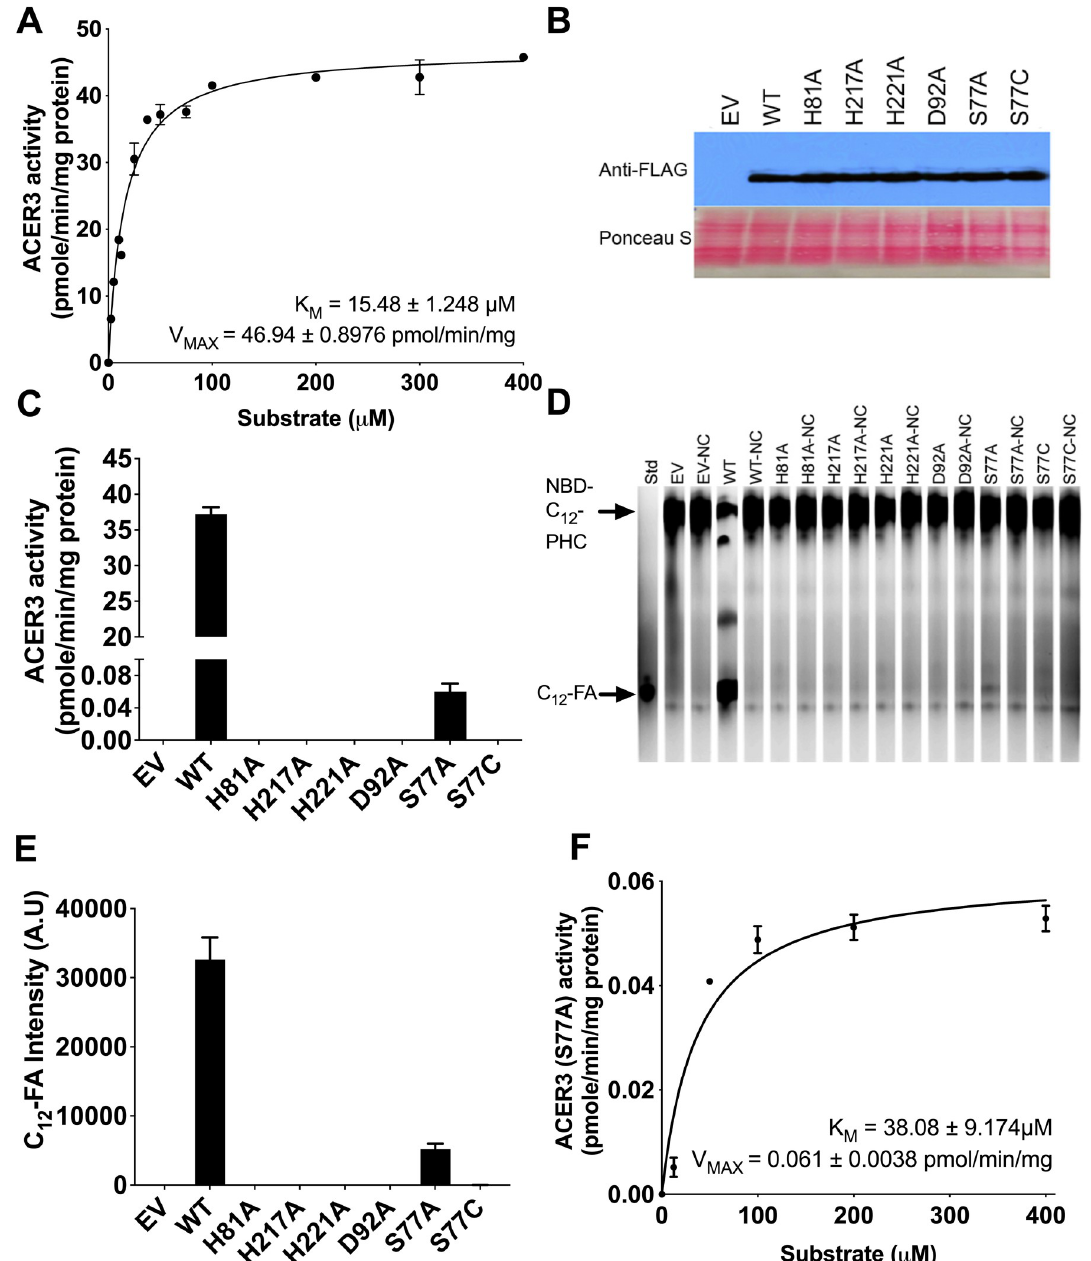
Fig 2. The kinetics of ACER3 and mutants. (A) Microsomes from yeast cells ( Δ Ypc1 Δ Ydc1 )overexpressing wild-type ACER3 were measured for in vitro ceramidase activity on various concentrations of NBD-C12-PHC. K M and V MAX values are indicated. Reactions were conducted with 1 μ g of microsome at 37˚C for 30 min. Data represent the mean ± S.D. of three independent experiments performed in duplicate. (B) Western blot analysis verifying the expression levels of each mutant and wild-type ACER3. For normalization of equal loading, the membrane blot was stained by ponceau S. (C) Microsomes from wild-type and each mutant ACER3 were subjected to alkaline ceramidase activity using NBD-C 12 -PHC. The release of the fluorescent product NBD-C 12 -FA from the substrate NBD-C 12 -PHC was detected by HPLC. (D) Microsomes from wild-type and each mutant ACER3 were subjected to alkaline ceramidase activity using NBD-C 12 -PHC. The release of the fluorescent product NBD-C 12 -FA from the substrate NBD-C12-PHC was detected by TLC. NC, Negative Control (heated microsomes) (E) Intensity of C 12 -FA in (D) was measured by ImageJ (NIH, 1.53a) (F) Microsomes from yeast cells ( Δ Ypc1 Δ Ydc1 )overexpressing mutant ACER3 (S77A) were measured for in vitro ceramidase activity on various concentrations of NBD-C12-PHC. K M and V MAX values are indicated. Reactions were conducted with 1 μ g of microsome at 37˚C for 30 min. Data represent the mean ± S.D. of three independent experiments performed in duplicate.